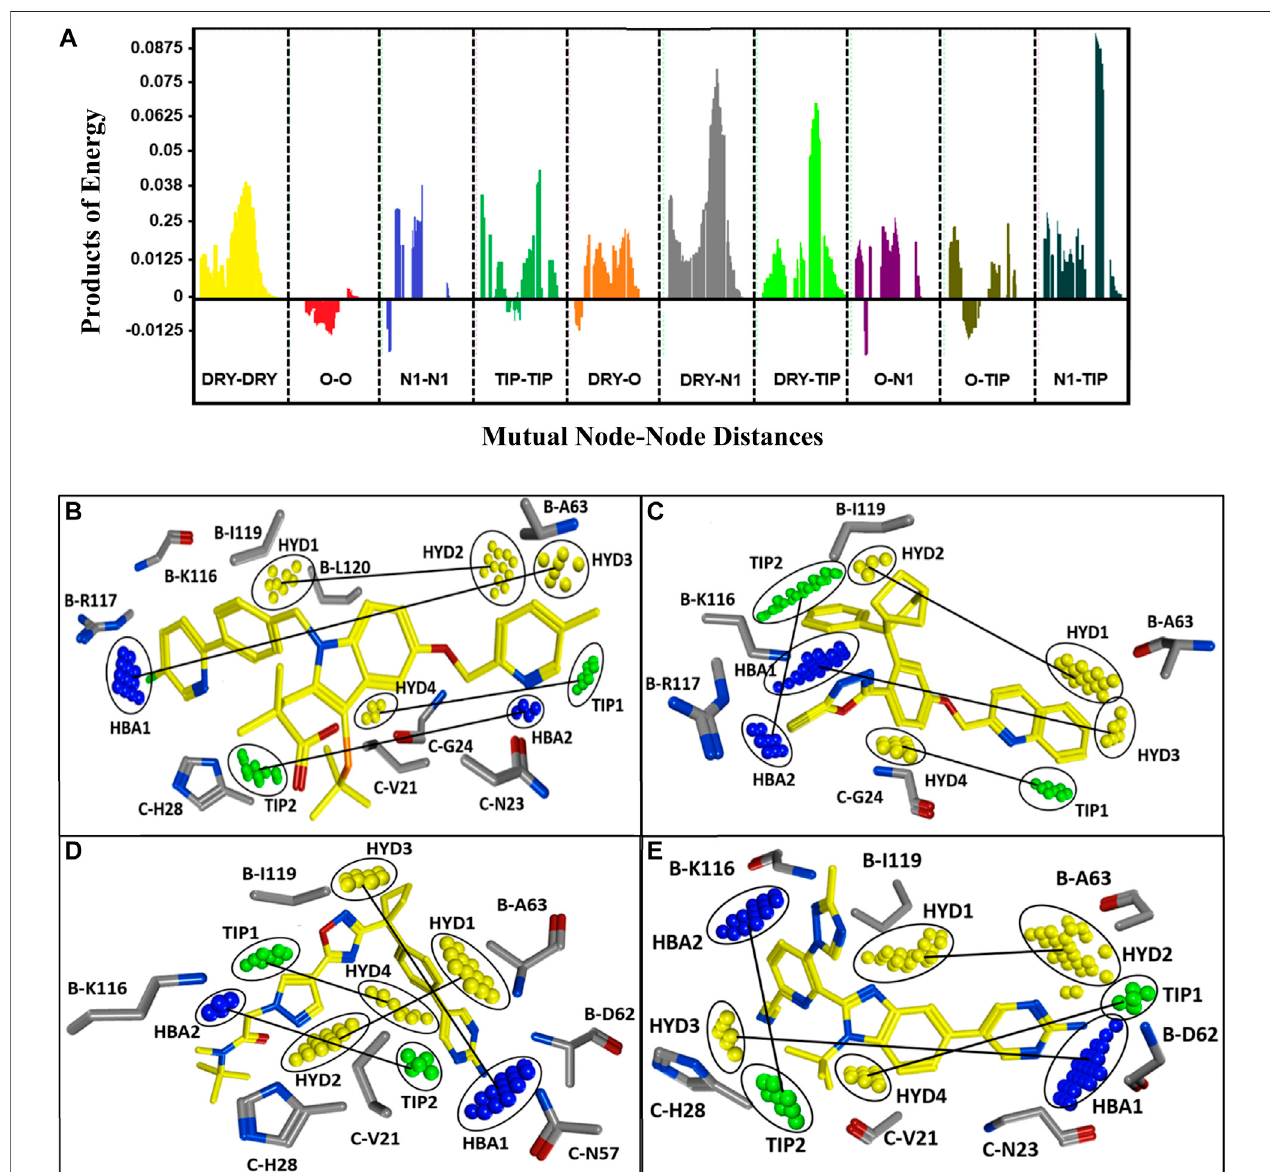
FIGURE 5 | (A) Correlogram of PLS coef fi cients representing the pair of probes contributing positively (peaks above 0) or negatively (peaks below 0) towards the inhibitory potencies of training set compounds. The positive contribution towards pIC 50 of FLAP inhibitors has been depicted by DRY-DRY (two hydrophobic), DRY-N1 (one hydrophobic and one hydrogen bond acceptor), DRY-TIP (one hydrophobic and one steric), and N1-TIP (one hydrogen bond acceptor and one steric) variables. The variables are present in all highly active FLAP compounds and are located at mutual distances of 16.00 – 16.40 Å, 16.40 – 16.80 Å, 18.00 – 18.40 Å, and 17.20 – 17.60 Å,respectively. (B) Theidenti fi edhotspotsonmostactiveindole-basedFLAPinhibitor(compound1)oftrainingsetwithprojectionofactualFLAPstructure. Hydrophobic features are depicted in yellow, hydrogen bond acceptors are in blue, while steric hotspots are depicted in green color. The two hydrophobic hotspots (HYD1andHYD2)arelocatedbetweentwoaromaticmoieties,onehydrophobic(HYD3)andonehydrogenbondacceptorfeature(HBA1)arepresentbetweenaromatic rings and terminalnegativeionizablesubstitution,onehydrophobic(HYD4)and steric feature (TIP1) canbespottedbetweenaromatic ring andindole scaffold, while one hydrogen bondacceptor(HBA2)andonesteric(TIP2)hotspotarepresentbetweendimethylbutanoicacidandpyridinering. (C) Themostactivecompound(compound 10) of class II with mapping of complemented amino acids on the recognized contours. (D) The most active of class III (compound 7), which is also the most active compound from oxadiazole-based FLAP antagonists (classes III, IV, and V) and mapped hotspots along with projection of complementary amino acids of FLAP binding cavity. Due to high structural similarity, the features were also observed at the same positions in all active compounds of classes IV and V. (E) The compound (70) from class VI with identi fi ed hotspots and corresponding amino